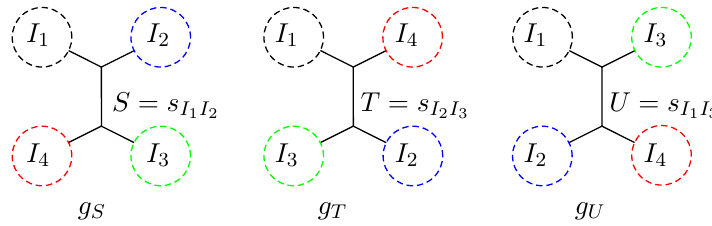
Figure 1. A triplet of three cubic tree graphs that di(cid:11)er by one